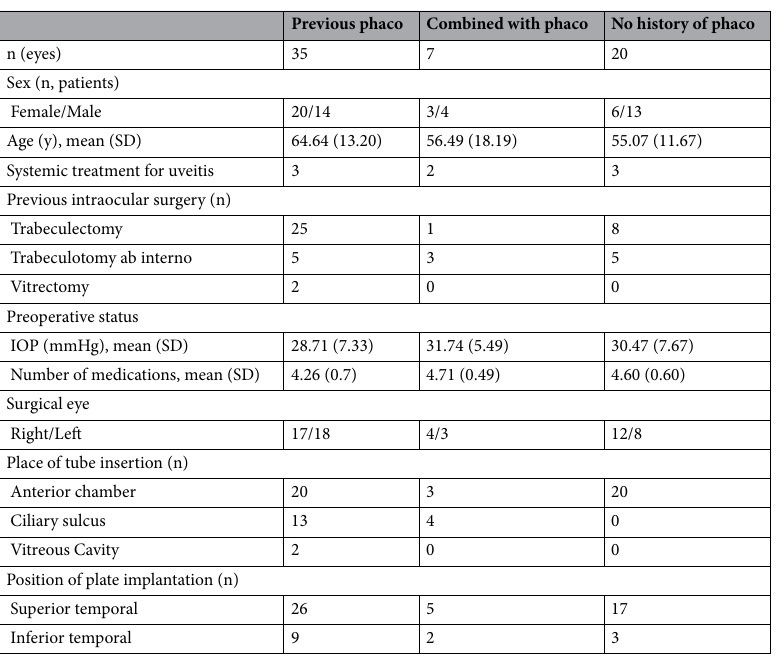
Table 5. Demographic data for three groups classified by history of phaco. N, number; phaco, phacoemulsification; SD, standard deviation; IOP, intraocular